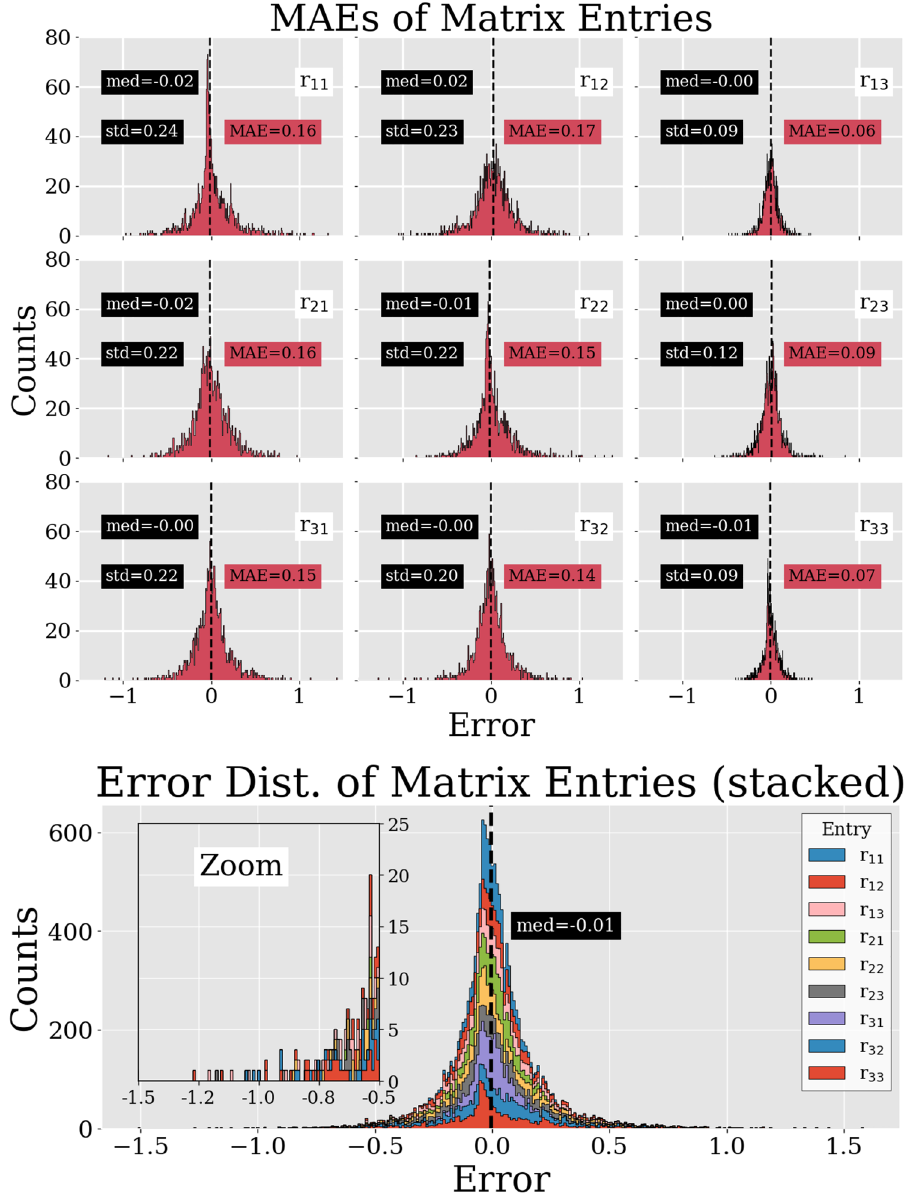
Fig. 7 Top graph: Error distri- bution of all matrix entries with entry-specific ( r 11 – r 33 ) mean absolute error (MAE), median (med), and standard deviation (std). Bottom graph: Stacked overlay of the individual error distributions (top nine graphs) with an enlarged section in order to conceptualize the idea of the amount of larger errors. Both top and bottom graphs are based on the Mix4 test